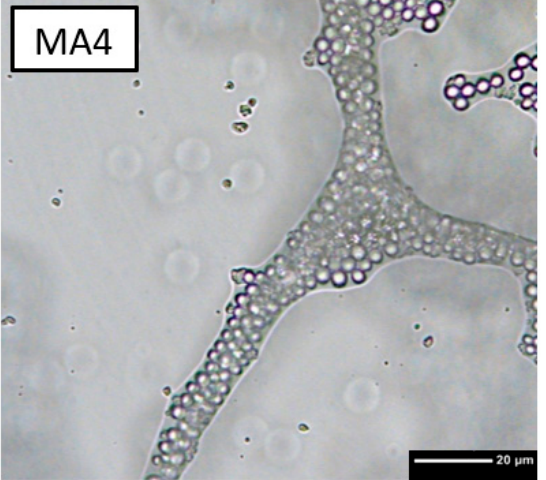
Figure 3. Three-dimnsional crosslinked structures with 40 wt% PMMA and ß-TCP in water under transmission microscope.